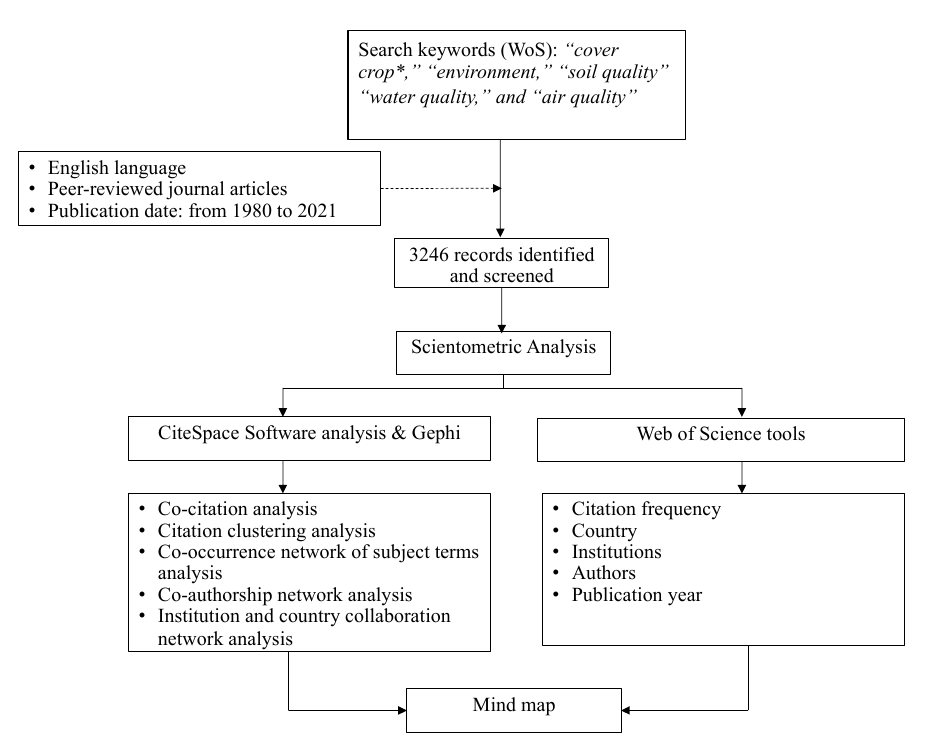
Figure 1. A schematic of the research design.